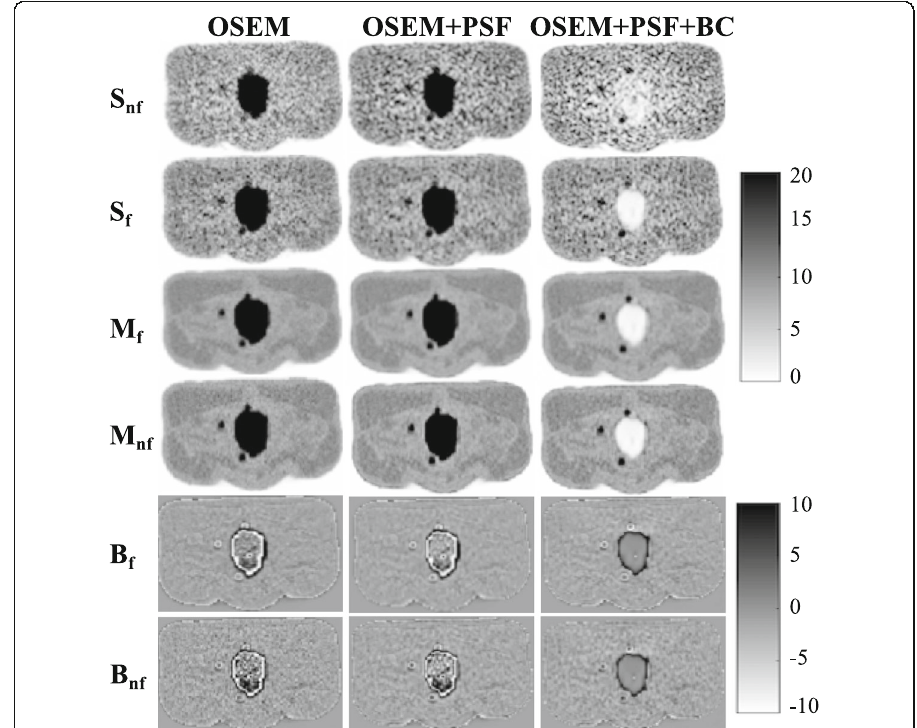
Fig. 7 Images showing improvement in lesion detection and reduction of bias around bladder edges with the correction technique. This is shown for bladder SUV 55.5 and lesion diameter 10mm at 20 full iterations. S f and S nf are the single noise realisation images with and without filtering, respectively, while M f and M nf are the mean images from 20 noise realisations with and without filtering respectively. B f and B nf are the bias images (i.e. difference between the mean image and the true simulated image) with and without filtering respectively. The bias image in OSEM+PSF+BC was estimated by first removing the bladder from the true simulated image